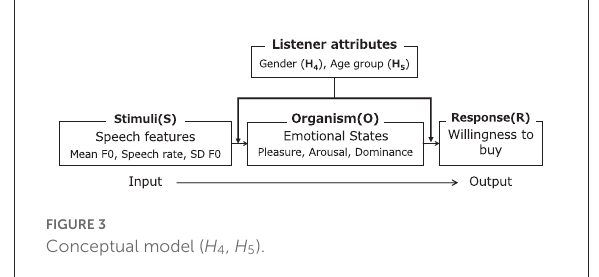
FIGURE3 Conceptual model ( H 4 , H 5